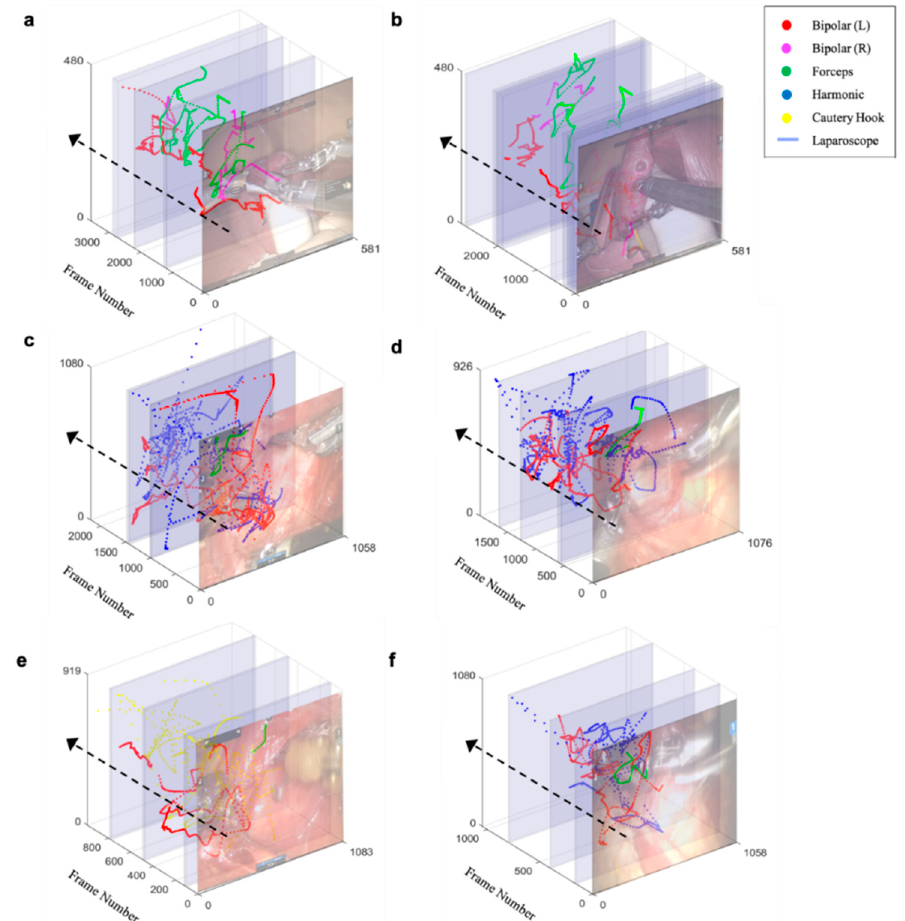
Figure 4. Trajectory of multi-surgical instrument tip. Each color represents a type of surgical instrument, and the blue area represents the duration of laparoscopy. ( a , b ) Trajectory of novice surgeons. ( c , d ) Trajectory of skilled surgeons. ( e , f ) Trajectory of expert surgeons.